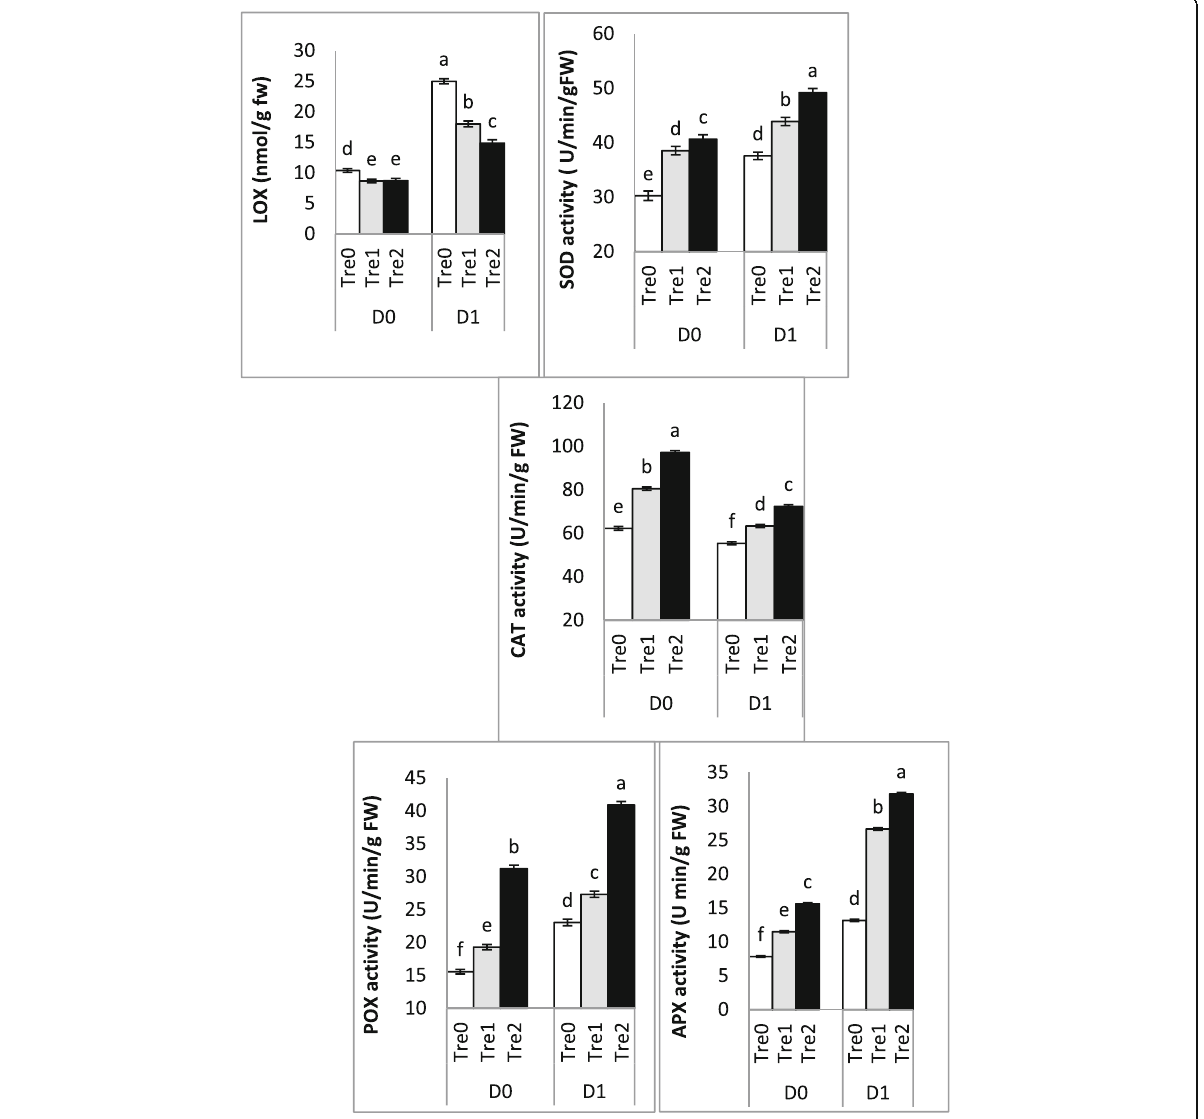
Fig. 4 Effect of trehalose (Tre1, 0.1 mM and Tre2, 0.5 mM) on LOX activity (nmol/g FW) and antioxidant enzyme activities (SOD, CAT, POX, and APX) (U/min/gFW) of quinoa plant under drought stress (at 75 days from sowing); each value represents the mean ± standard error ( n = 3). Means with different letters above bars were significantly different at the 0.05 level according to Duncan ’ s multiple range